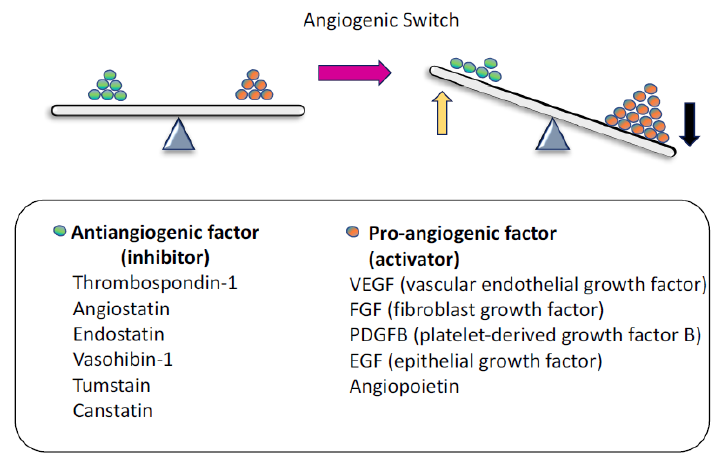
Figure 1. Angiogenesis is regulated by a balance of angiogenic and antiangiogenic factors. In angiogenesis, Pro-angiogenic supporters activate endothelial cells (ECs). In contrast, antiangiogenic factors suppress EC activation. When the angiogenic switch is turned on, there are more angiogenic (black arrow) than antiangiogenic factors present (yellow arrow).